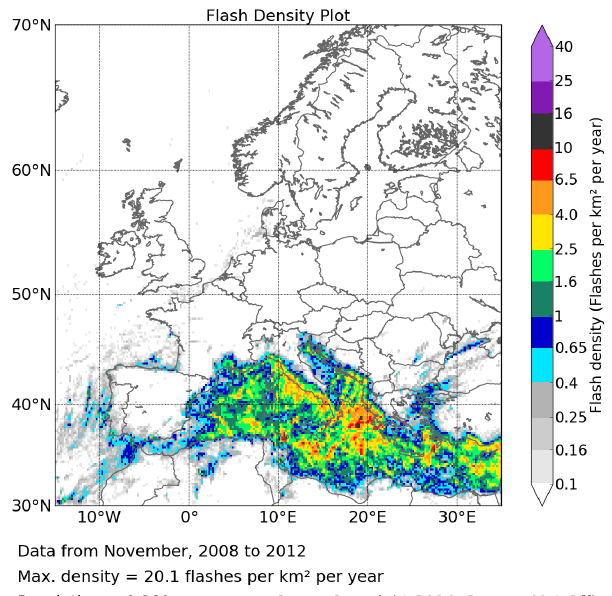
Fig. 15. Detected lightning flash density for November.